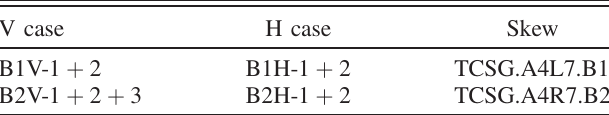
TABLE IV. Collimator configurations used for skew collimator predictions in loss map case